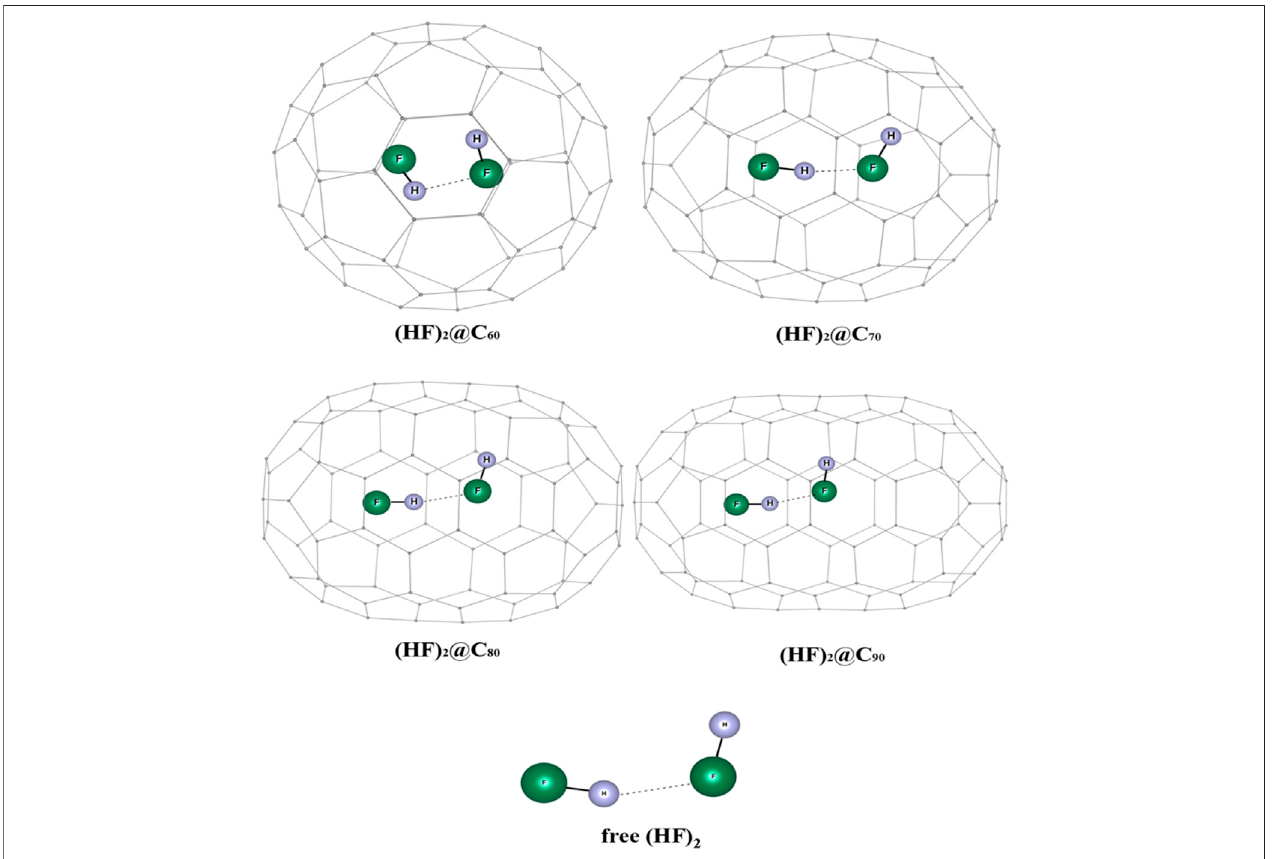
FIGURE 15 | Optimized structures of (HF) 2 @C n ( n (cid:1) 60, 70, 80, 90) and free (HF) 2 at ω B97X-D/6-31G level. (Reprinted from Khatua et al., 2014b with permission from Elsevier. Copyright© 2014, Elsevier B.V.).